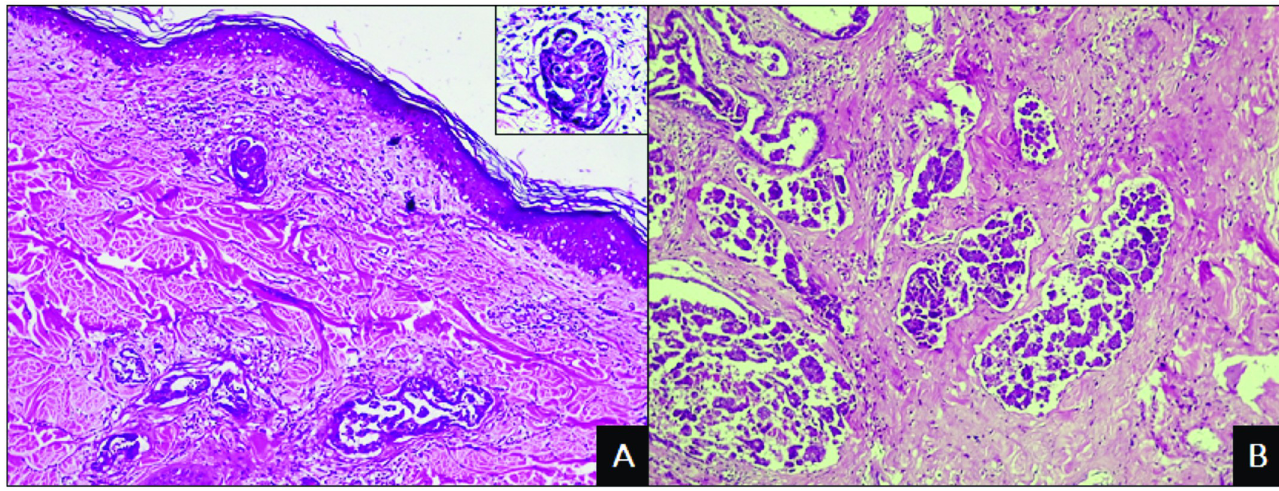
Fig 2. Photomicrographs of inflammatory mammary carcinoma in female dogs. A) Proliferation of neoplastic cells in the superficial dermis associated with peritumoral inflammatory infiltrate. HE. Obj. 10x. Detail: Highly pleomorphic cells. HE. Obj. 40x. B) Proliferation of neoplastic cells invading the mammary parenchyma with developed stromal support. HE. Obj.